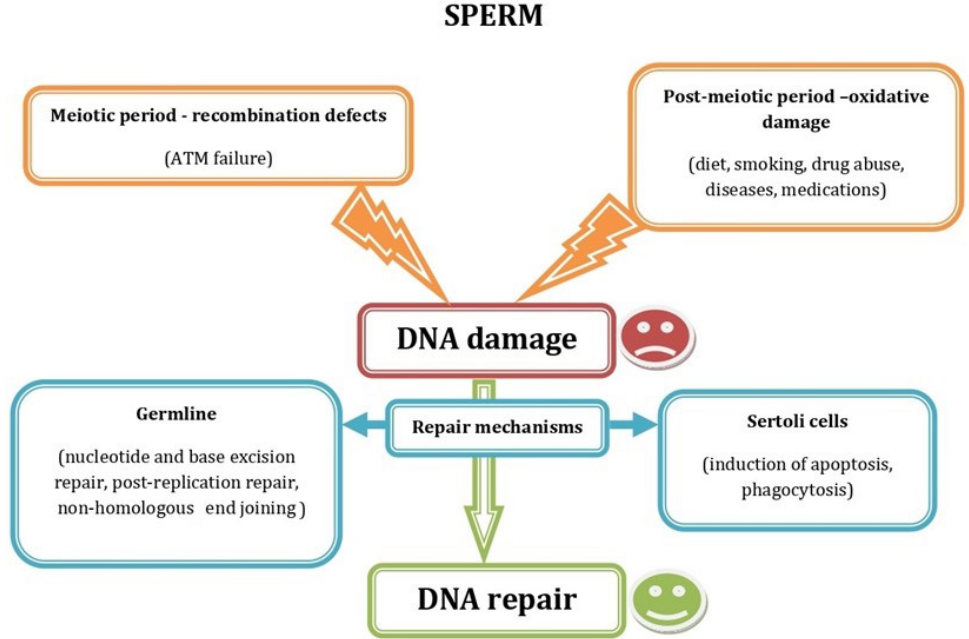
Figure 1. Schematic representation showing the most common factors causing sperm DNA damage during the meiotic and the postmeiotic period and the DNA repair mechanisms acting in germ and Sertoli cells.